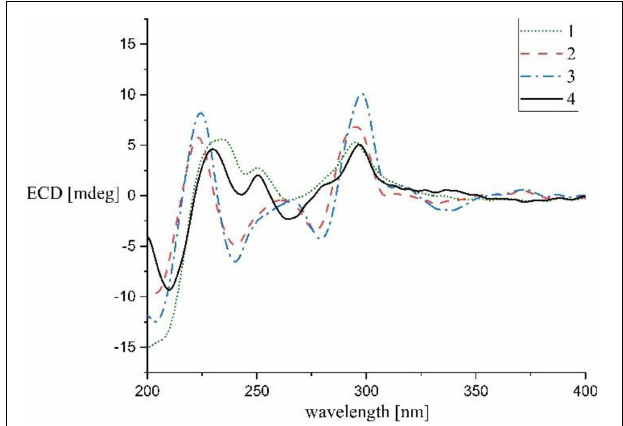
FIGURE 4 | Experimental ECD spectra of compounds 1 – 4